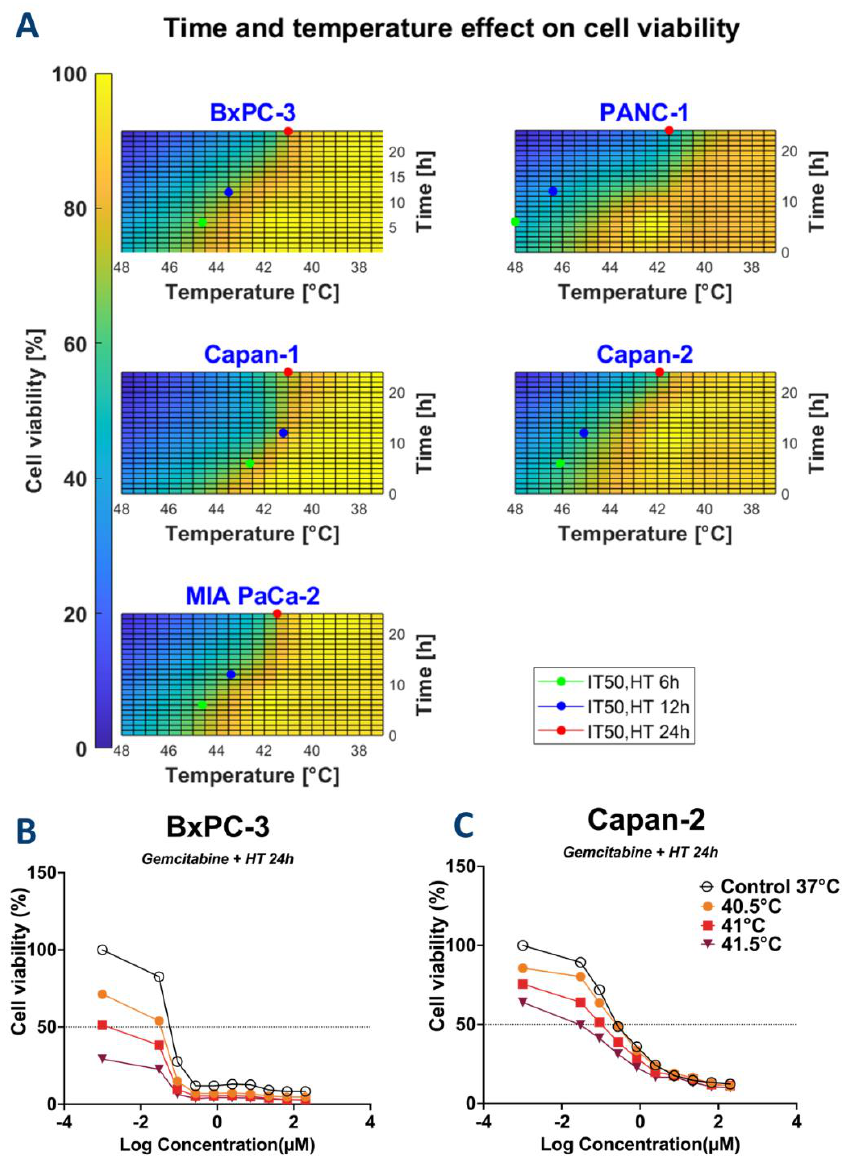
Figure 4. Combination of time and temperature effects on cell proliferation as illustrated by heatmaps for the calculation of IT 50,HT and IC 50,drug for thermal therapy ( A ) Heatmaps showing the relative cell viability in function of time and temperature were used to calculate IT 50, HT for thermal therapy. IT 50,HT values are shown for each of the cell lines at 6-, 12-, and 24 h. Heatmaps show that treatment duration increases the cytotoxic effect of thermal therapy observed by a lower IT 50,HT (i.e., lower temperatures are needed to decrease cell viability by half of its maximal effect). ( B , C ): Dose curve response of BxPC-3 and Capan-2 to gemcitabine for 24 h.